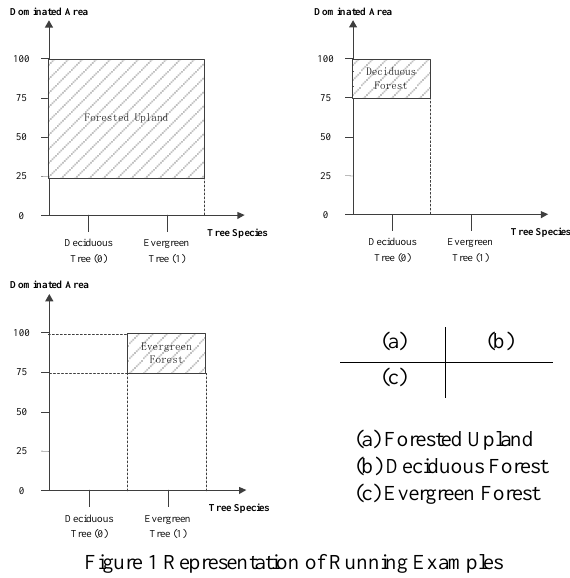
Figure 1 Representation of Running Examples in the Geometric